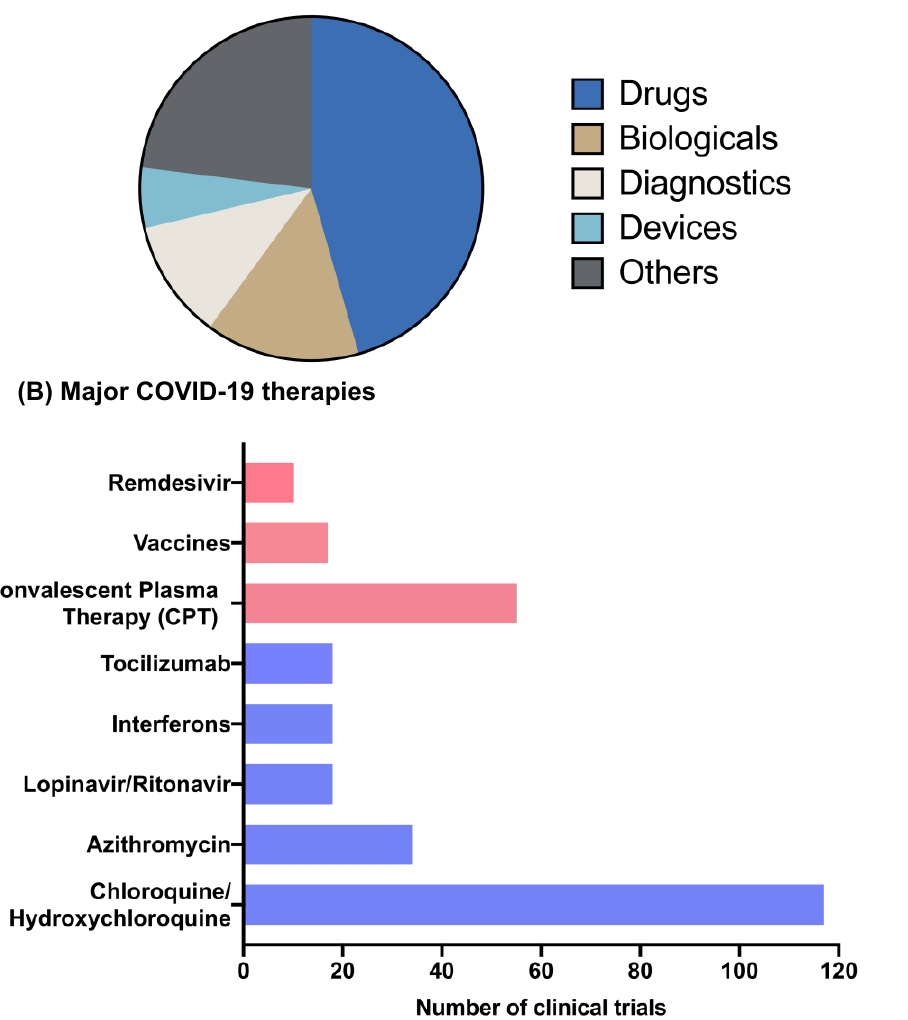
Figure 2. Clinical trials for COVID-19 treatment. ( A ) Distribution of COVID-19 clinical trials. Twelve hundred and sixty-five clinical trials are registered for COVID-19, which can be classified into drugs, biologicals, diagnostic tests, devices (respiratory, oxygen therapy, etc), and others (procedures, dietary supplements, etc). Four hundred and forty-seven drug candidates including repurposed and investigational are currently being tested at different stages of clinical trials for COVID-19 treatment. Furthermore, the efficacy of one hundred and forty-three biologicals including vaccines, convalescent plasma therapy, monoclonal antibodies, and stem cells is also being tested for COVID-19. ( B ) Graphical representation of major therapies against COVID-19 based on number of clinical trials. Chloroquine/hydroxychloroquine is being evaluated in one hundred and seventeen clinical trials for COVID-19 either alone or in combination with additional antiviral or immunomodulatory agents. Convalescent plasma is another major investigational therapy whose efficacy is now being evaluated in fifty-five clinical trials for COVID-19 treatment.